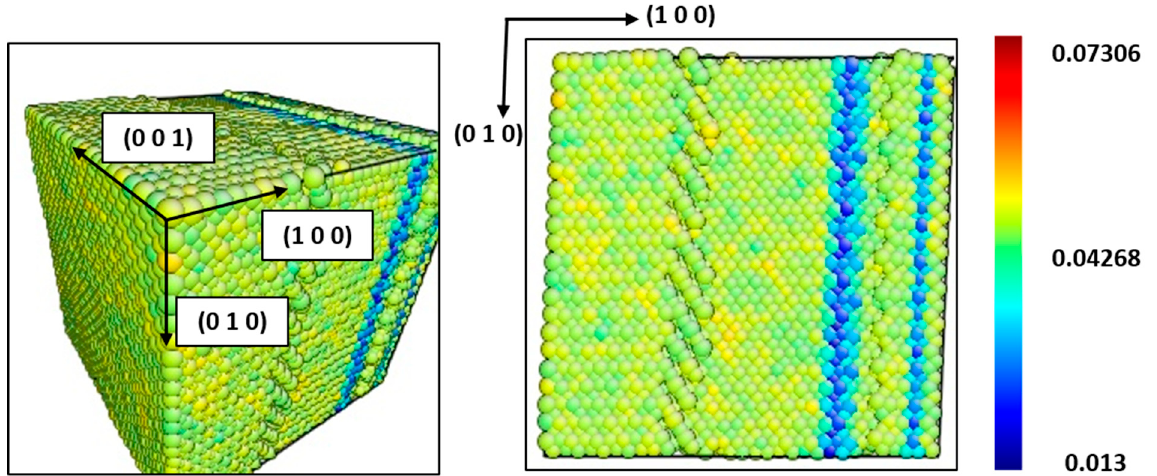
Figure 6. Atomic structure from simulation domain at 10 K under normal and shear stresses of 0.1 GPa. Atoms were colored by local von Mises shear strain invariant. Martensite twin was formed as (1 0 0) (0 1 1).